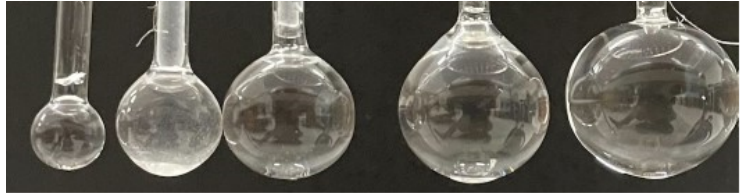
Figure 1. The glass tumour bulbs (filled with saline solution) used as tumour surrogates in the breast phantoms.